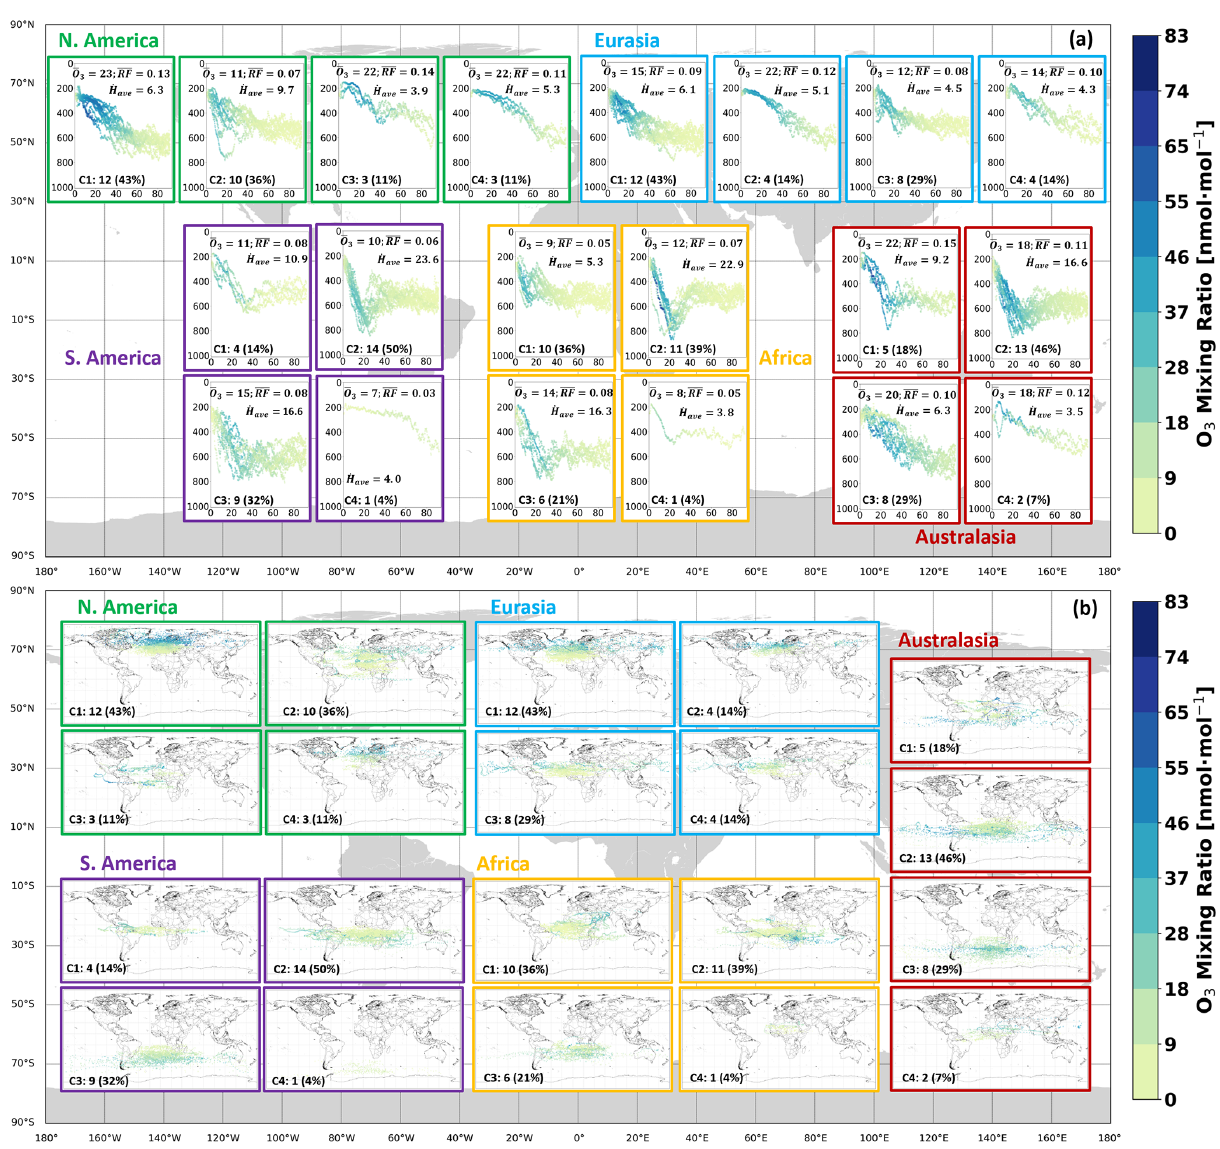
Figure 13. (a) Vertical profile of clusters of NO x transport pathways during July 2014. The color bar represents the mean O 3 disturbance in nanomoles per mole (nmolmol − 1 ) caused by the emission of a median trajectory. Each “C” represents a distinct and independent cluster; i.e., C1 from N. America is not related to C1 from S. America. Each cluster label is followed by the number of median trajectories that it comprises, both in absolute and relative terms. The 90d mean rate of descent in hectopascals per day (hPad − 1 ) for all median trajectories in a cluster is defined as ˙ H ave . The cluster radiative forcing contribution in milliwatts per square meter (mWm − 2 ) is labeled as RF, and O 3 is the mean disturbance of the median trajectories in nanomoles per mole (nmolmol − 1 ). Panel (b) uses the same notation but for the horizontal distributions. The axes for panel (a) are defined in Fig. 7a and b, while the axes for panel (b) are specified in Fig. 7c and d. Meteorological conditions considered are specific to the period 1 July–30 September